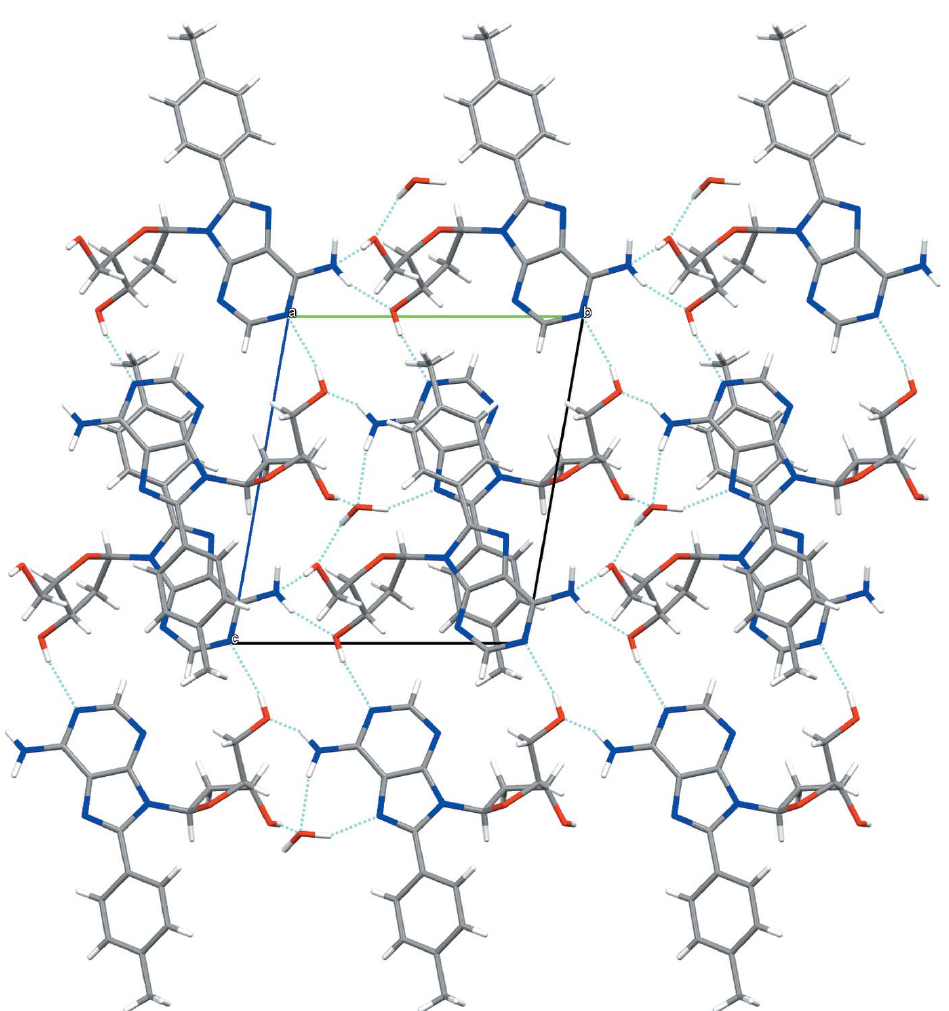
Figure 3 The crystal packing ( Mercury 3.19 ; Macrae et al. , 2006) viewed along the a axis, showing the classical hydrogen bonds forming a three-dimensional